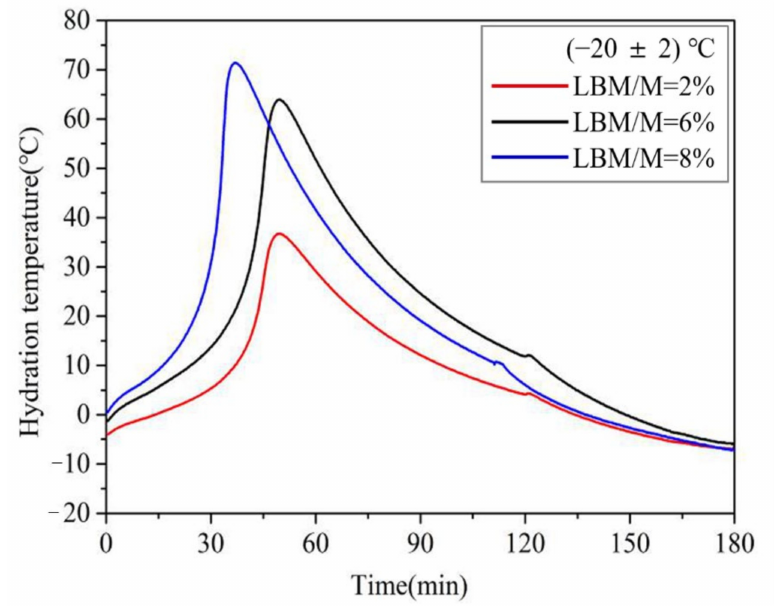
Figure 9. The influences of the LBM / M ratio on the rise in the reaction temperature of MPC at ( − 20 ± 2) ◦ C. The reaction process of the MPC can be divided into six stages: (i) the ADP hydrolysis period, + (ii) MgO dissolution period, (iii) Mg (H 2 O) 62 growth period, (iv) struvite growth acceleration period, (v) struvite growth deceleration period, and (vi) struvite growth stable period [30,36,37]. Among